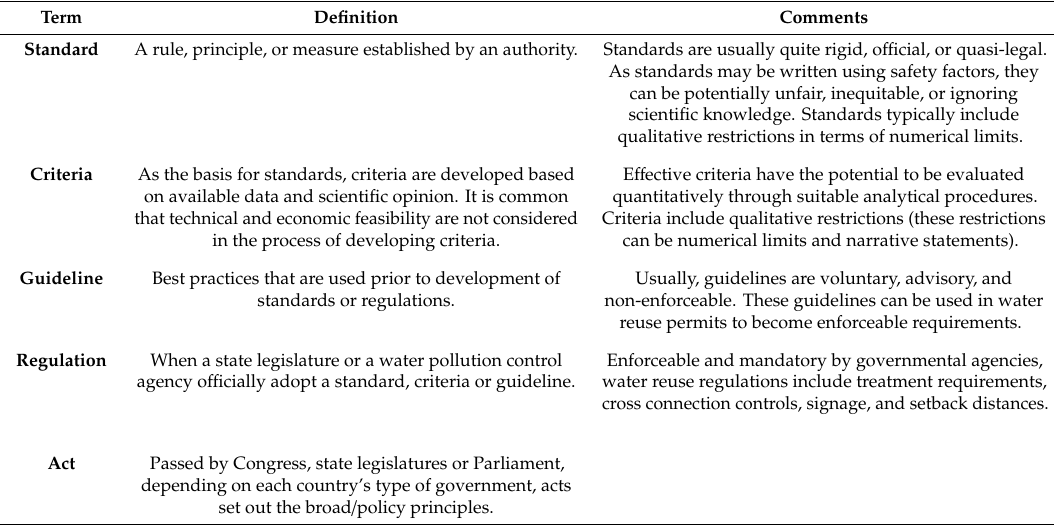
Table 2. The definition of standard, criteria, guideline, and regulation